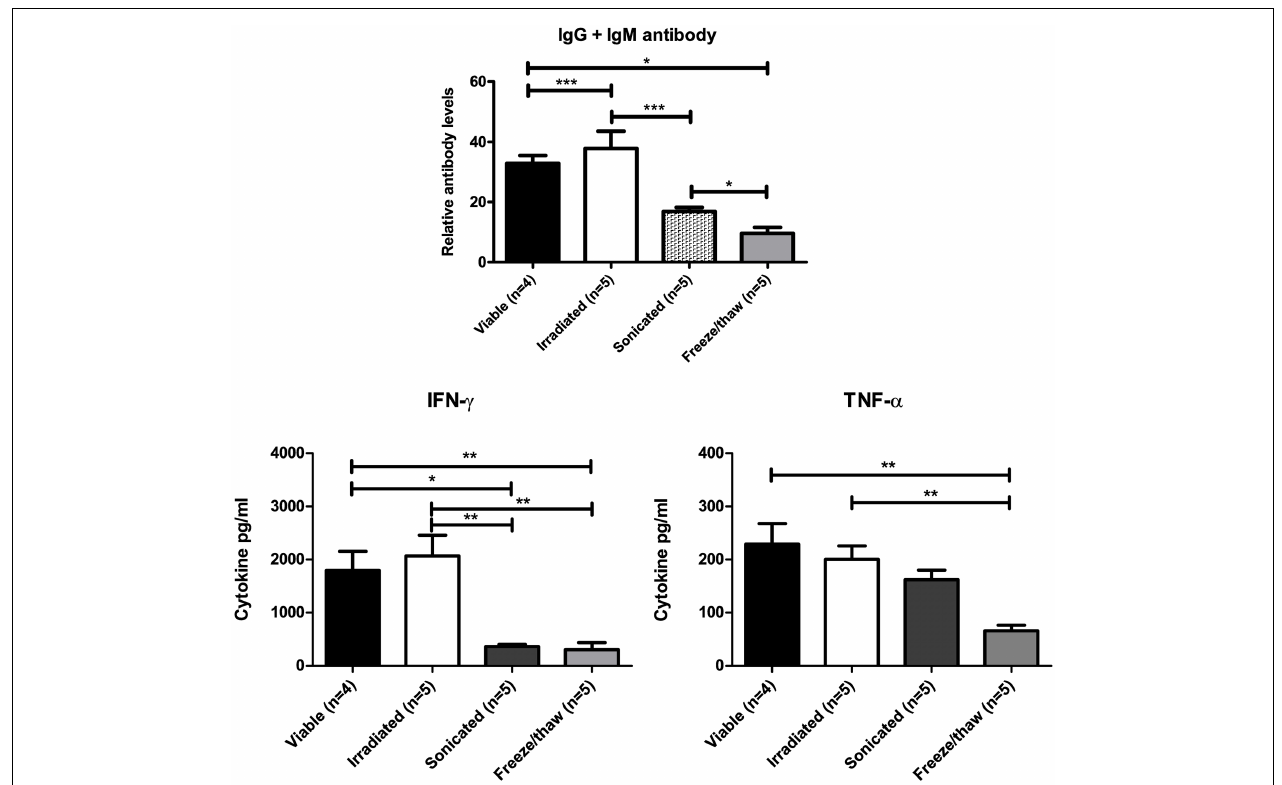
irradiated DFTD cells (Data are expressed as mean ± SEM, probability calculated by unpaired Student’s t -test, * P < 0.05, ** P < 0.01, and *** P <